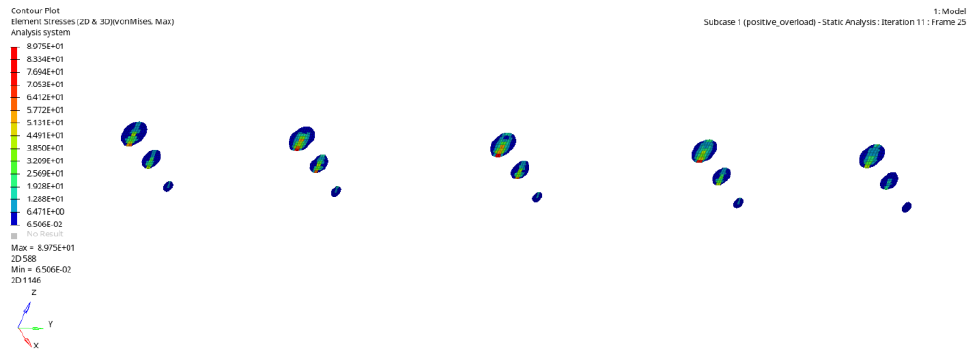
Figure 24. Stress of planar disk (condition D).